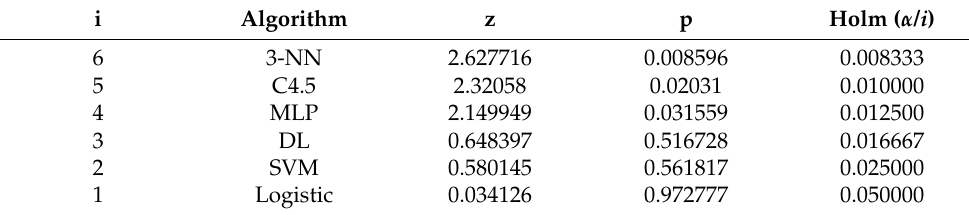
Table 8. Holm’s post hoc test for Balanced Accuracy.